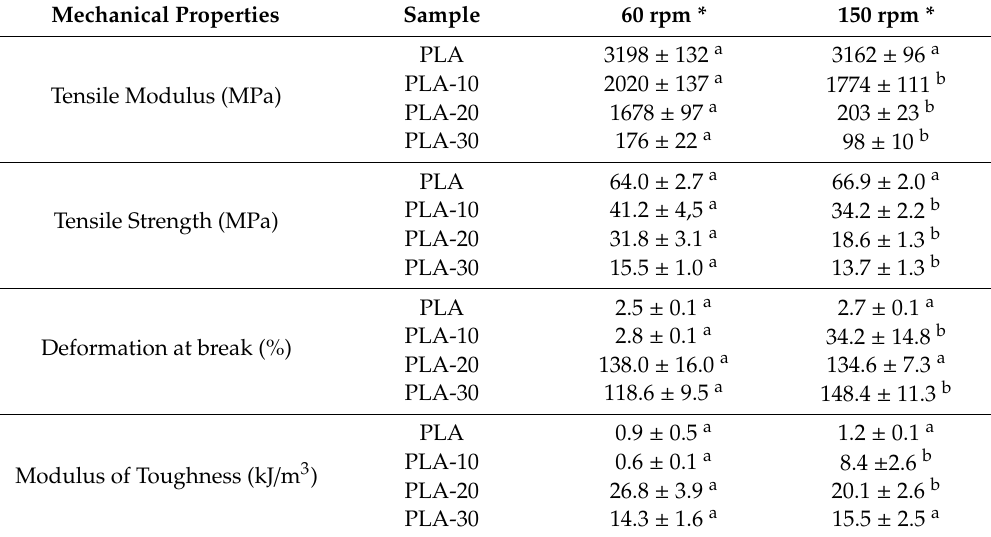
Table 2. Mechanical properties of the studied materials.